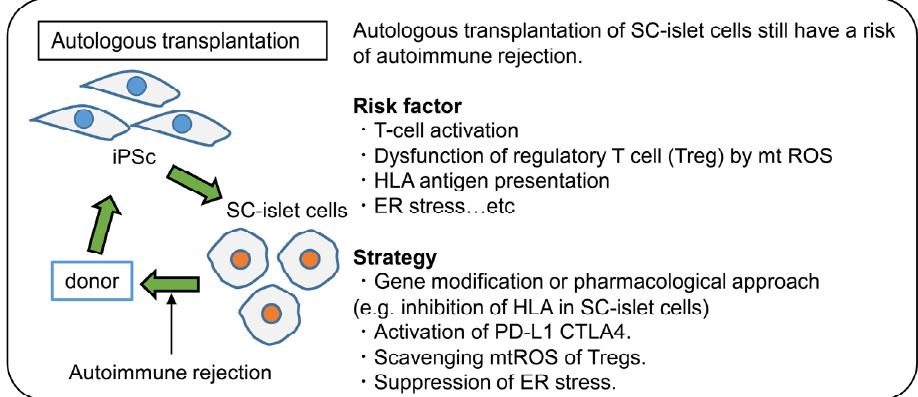
Figure 2. Autologous transplantation of SC-islet in T1D. Even the autologous transplantation of for rejection. Thus, there is a need to further understand the pathophysiology of the immune response in T1D. Furthermore, SC-islet has the potential for rejection. Thus, there is a need to further understand the pathophysi- strategies for avoiding the immune response are ology of the immune response in T1D. Furthermore, strategies for avoiding the immune response are required.